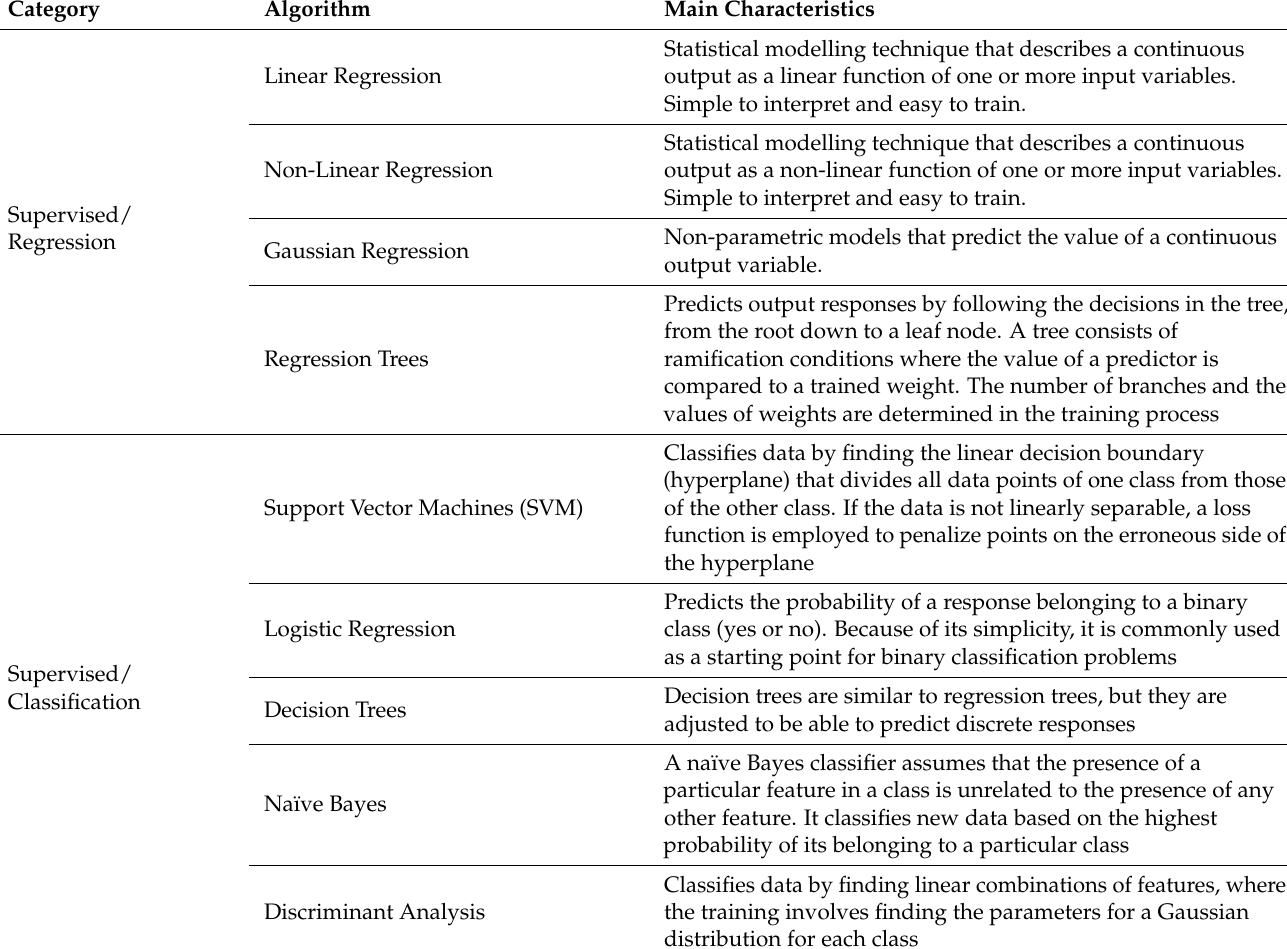
Table 5. Machine learning algorithms used in EEG